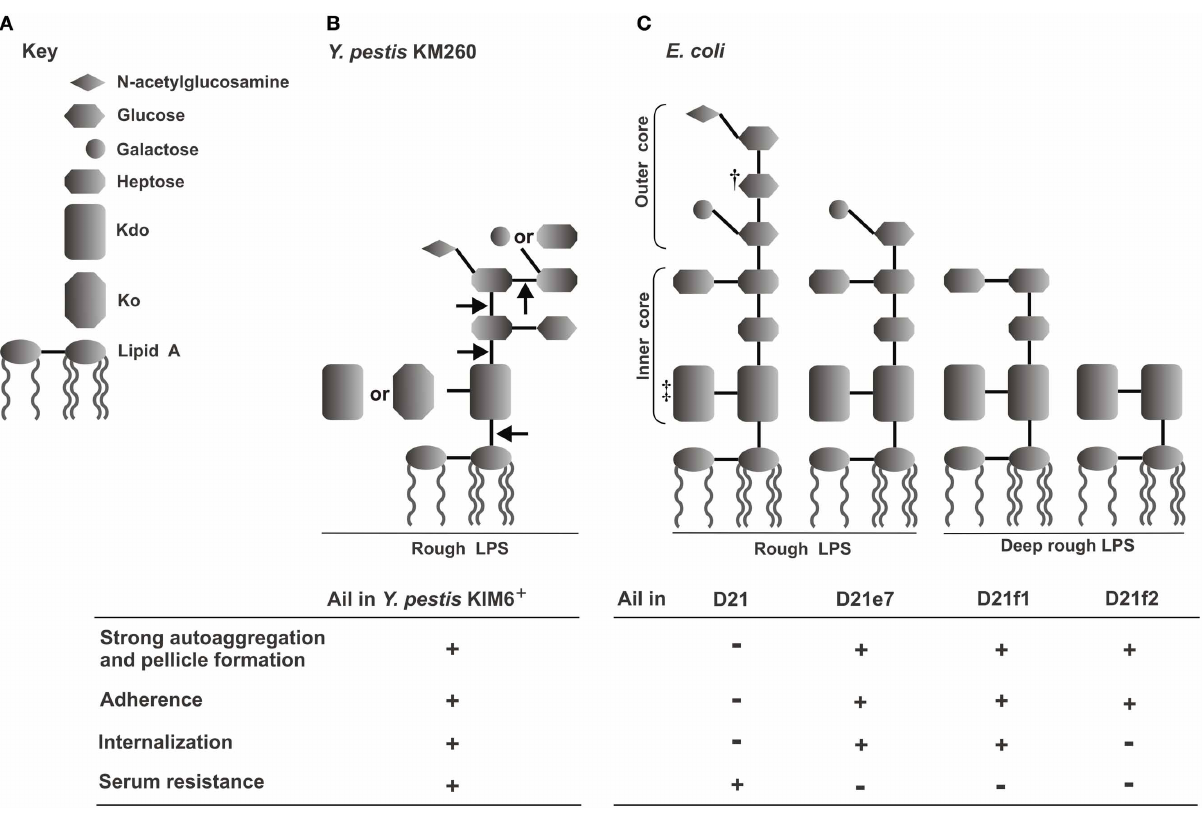
et al., 1998; Junkes et al., 2008; Prokhorenko et al., 2009). † , some sources indicate galactose (Junkes et al., 2008); ‡ , some sources indicate two or three KDO residues (Nikaido and Vaara, 1985). The table shows presence ( + ) or lack ( − ) of Ail-mediated phenotypes (autoaggregation and pellicle formation, adhesion to Hep-2 cells, internalization into Hep-2 cells, and human serum resistance) related to a particular strain (Kolodziejek et al., 2007,